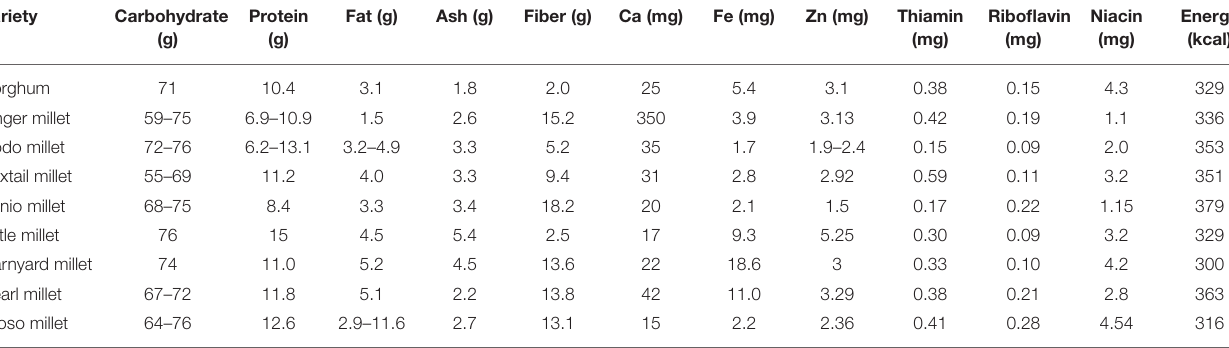
TABLE 1 | Proximate nutrient composition and nutritive value of various millets (g/100g db and mg/100g db).